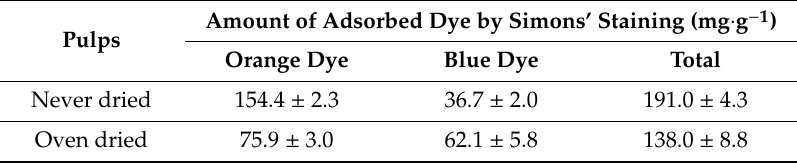
Table 4. Amount of adsorbed dye depending on drying methods.